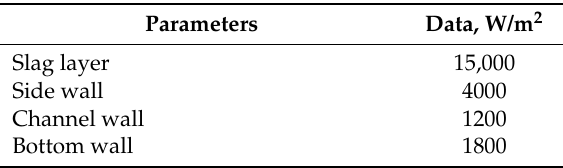
Table 7. Values of heat flux